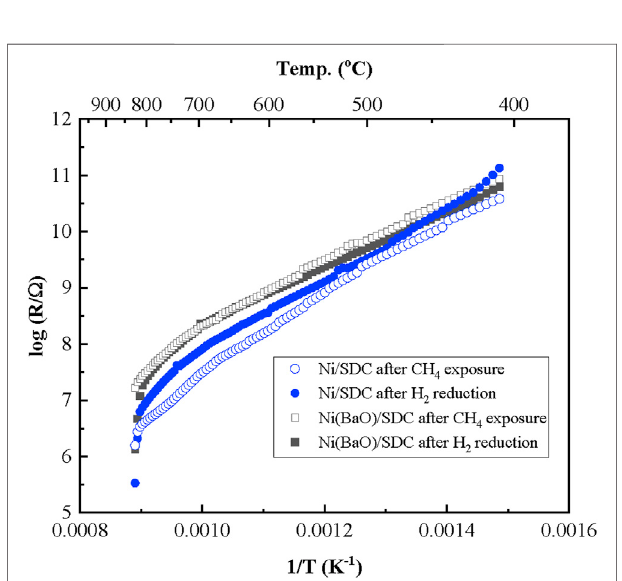
2 reduction (A) and